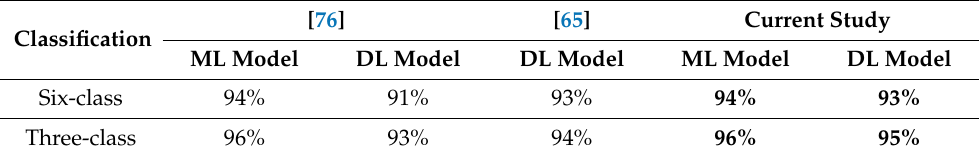
Table 11. Comparative analysis of the proposed models on the peer database (Pereyra et al. [61]) consisting 9029 samples. The accuracies are reported for individual model in each column. The best performances are highlighted in